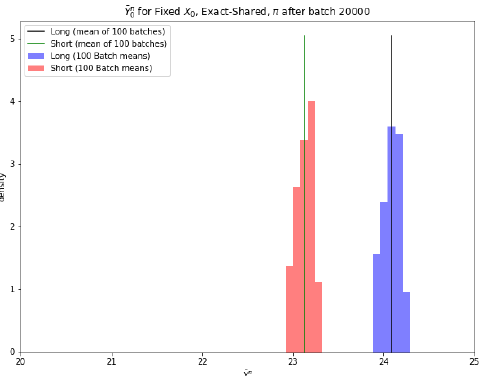
for the strategies after the 20,000th batch in 0